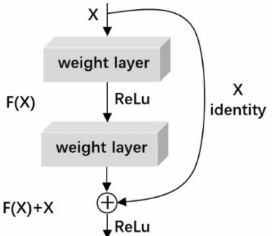
Figure 3. The structure of the residual